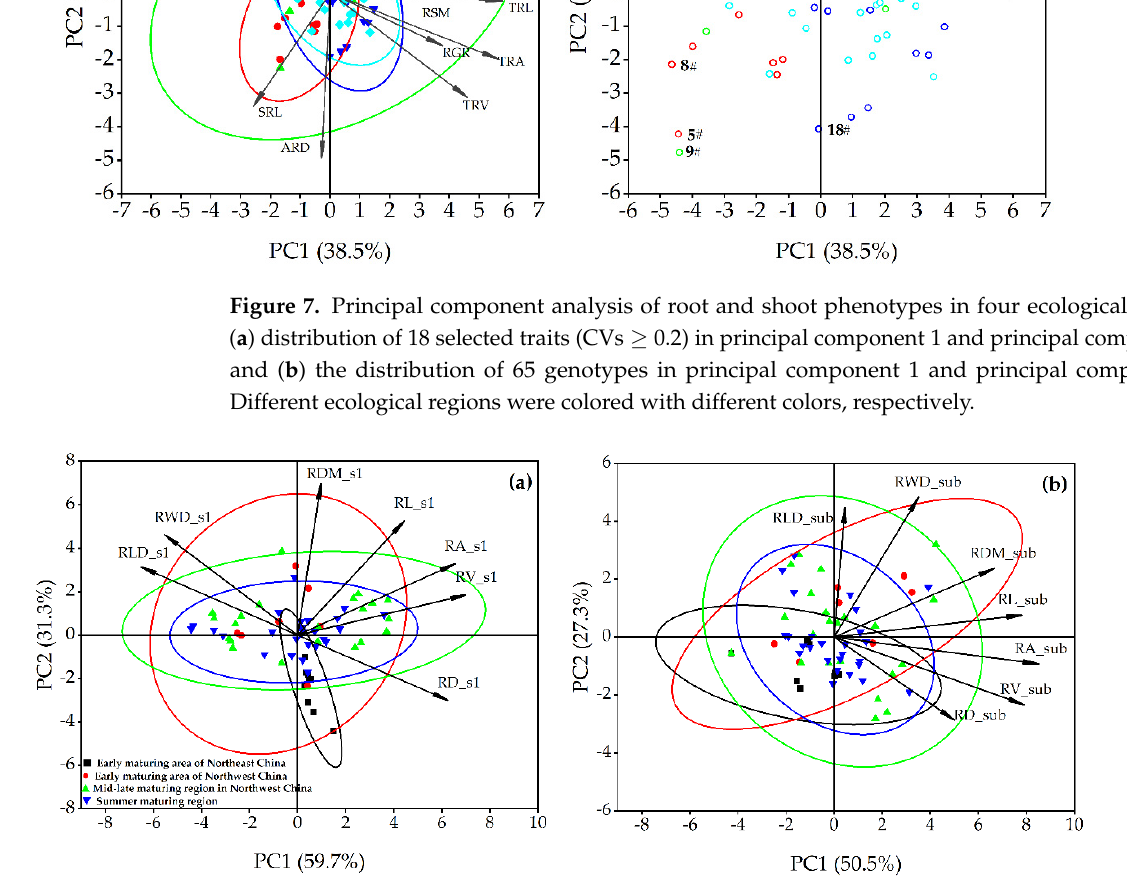
Figure 8. Principal component analysis of root phenotypes in the top layer (0 ‒ 5 cm section) and the sub-layer (below 5 cm section): ( a ) seven root traits in the top layer and ( b ) seven root traits in the sub-layer, with genotypes presented by ecological regions.